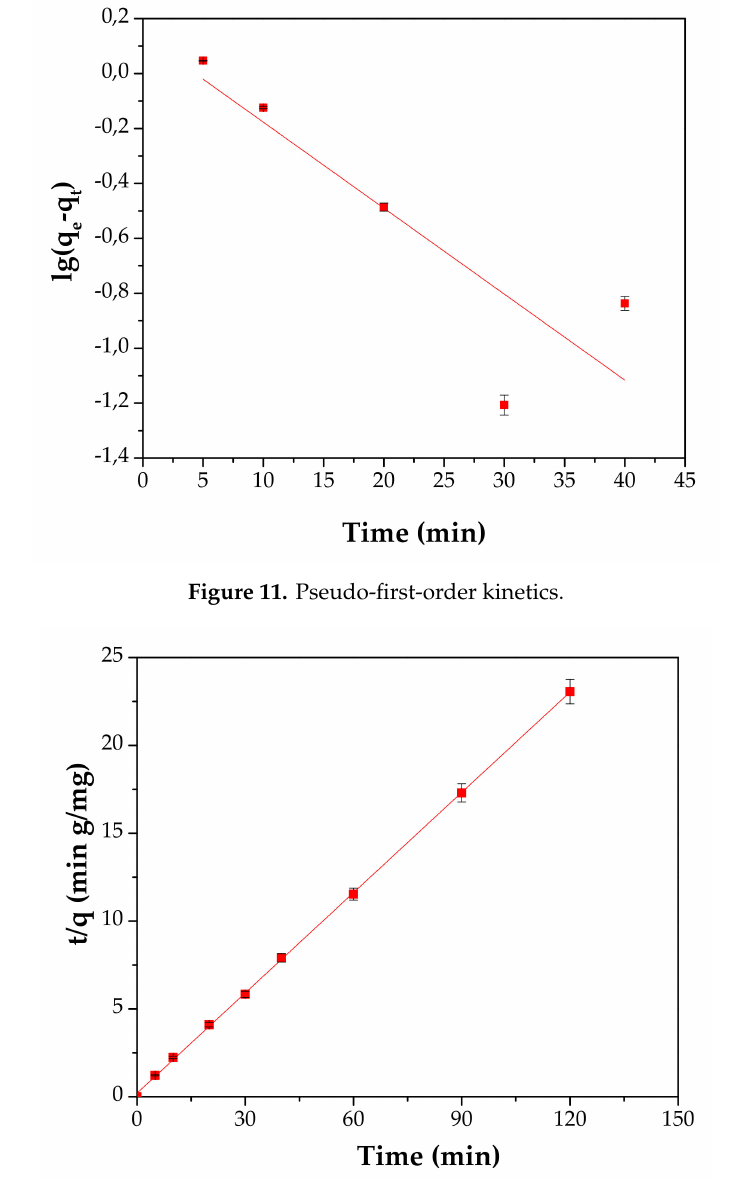
Figure 12. Pseudo-second-order